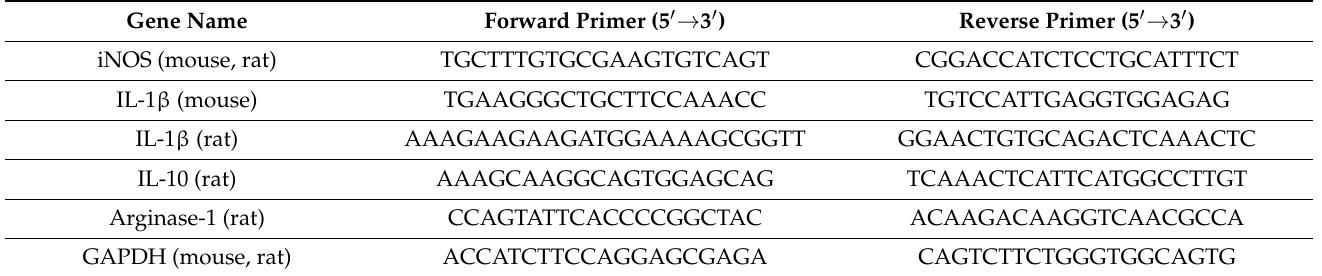
Table 1. Primer sequences used in the RT-PCR